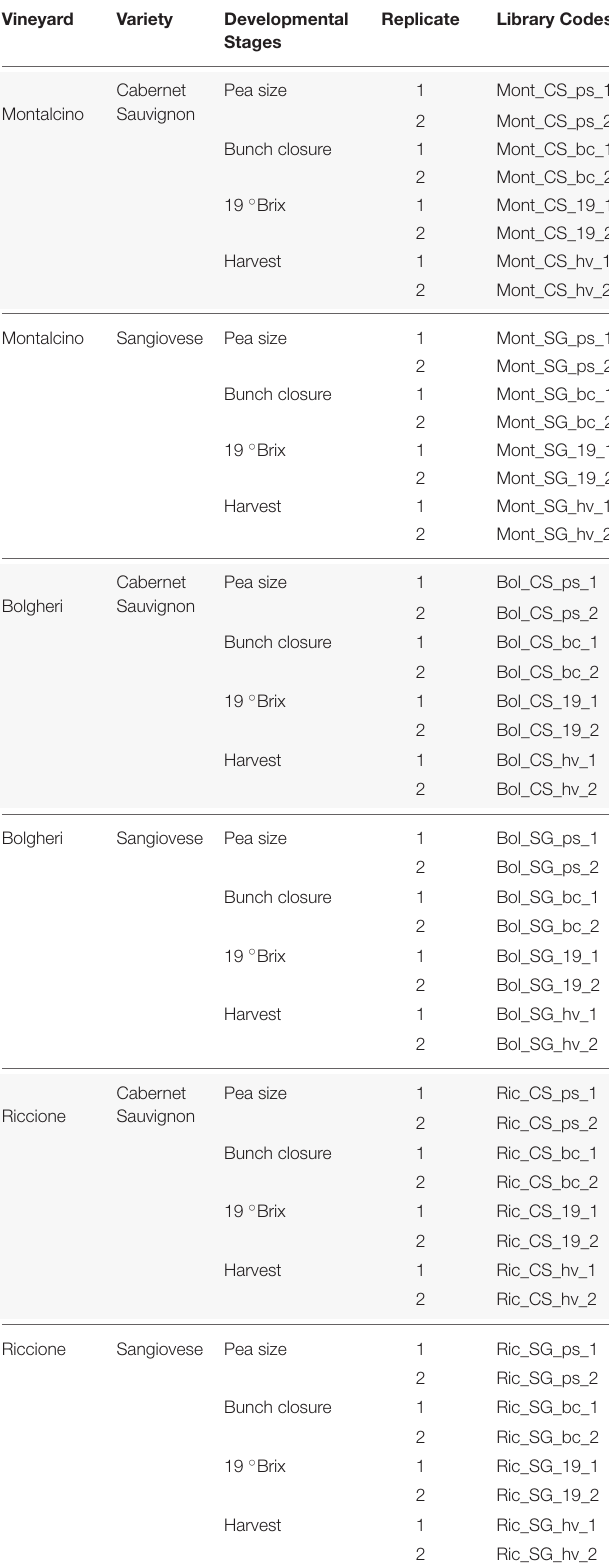
TABLE 1 | List of berry samples of Vitis vinifera used for the construction of the small RNA libraries. Vineyard